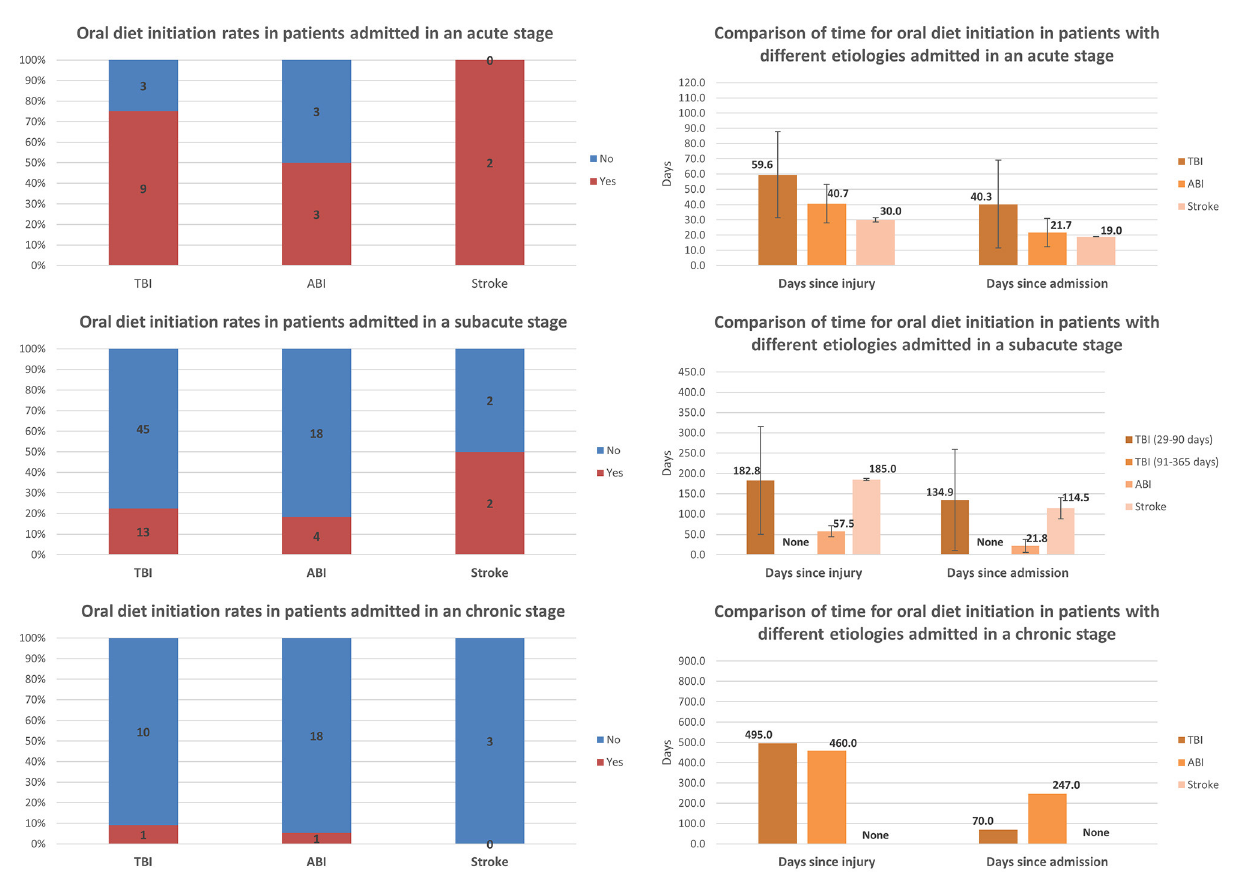
FIGURE4 Comparison of rates of oral diet initiation and the time to achieve oral diet initiation among patients with different etiologies and admitted at different stages post-injury (error bars represent standard